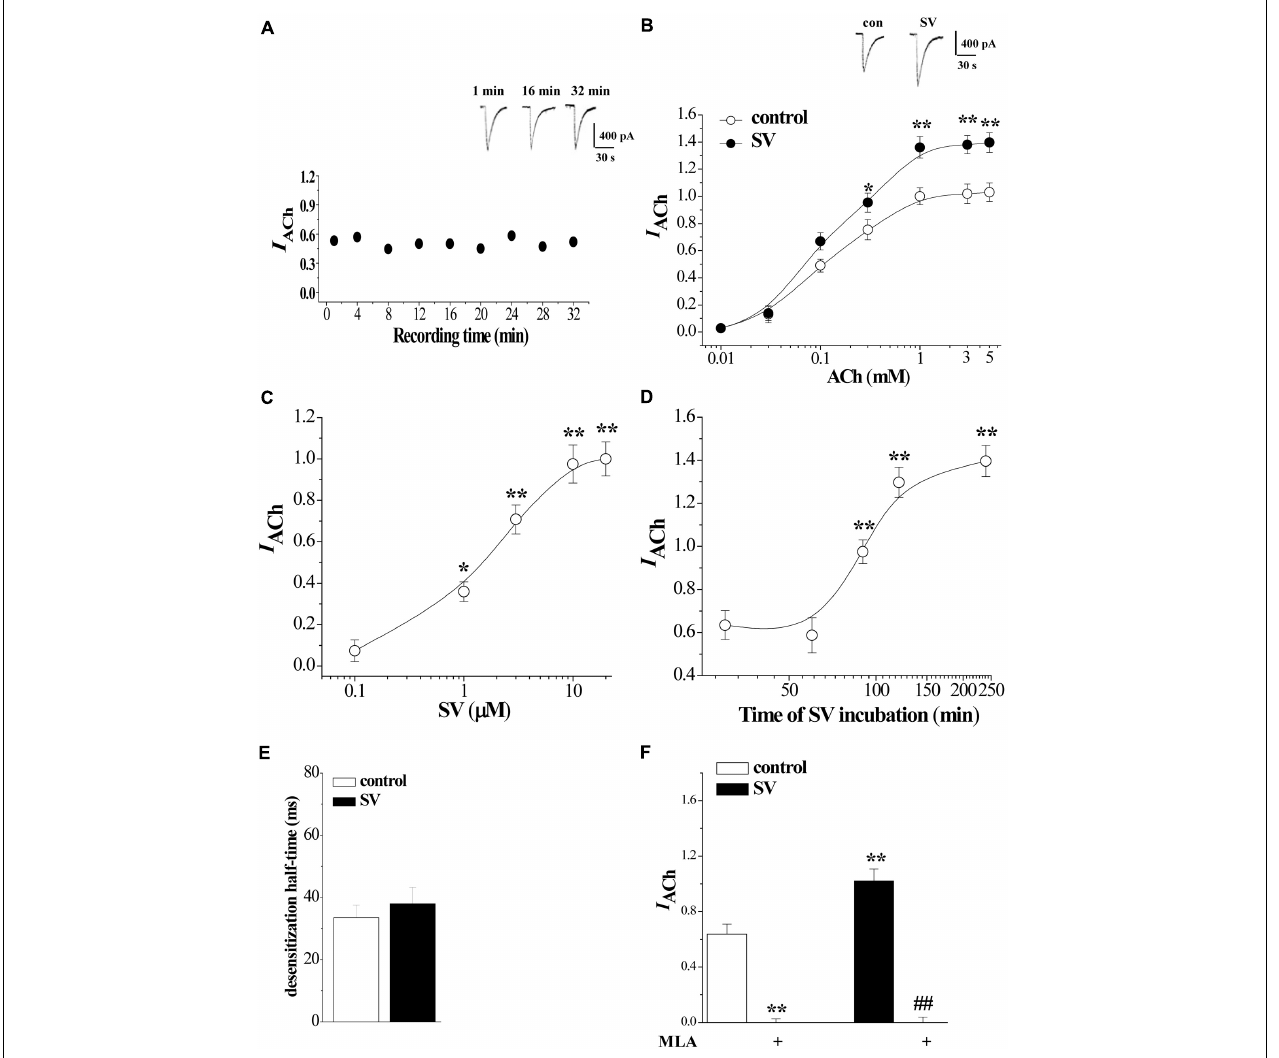
FIGURE 1 | Acute treatment with Simvastatin enhances α 7nAChR activity in hippocampal CA1 pyramidal cells. (A) Repeated applications of ACh (1.0 mM) with 4 min interval evoke whole cell currents ( I ACh ). Representative traces of I ACh evoked at the time of 1, 16, and 32 min. (B) The CA1 pyramidal cells were subjected to consecutive 1 sec applications of 0.01, 0.03, 0.1, 0.3, 1, 3, and 5 mM ACh. Dose-response curves were constructed by the amplitude of I ACh (means ± SEM) that were normalized by a control value evoked by ACh (3 mM). Representative traces of I ACh evoked by 1 mM ACh. ∗ P < 0.05 and ∗∗ P < 0.01 vs. control slices (repeated-measure ANOVA). (C) Evoked I ACh by ACh (1 mM) in the slices treated with SV at 0.1, 1, 3, 10, and 20 µ M for 2 h. Dose-response curves were constructed by the amplitude of I ACh (means ± SEM) that were normalized by the treatment with 10 µ M SV. ∗ p < 0.05 and ∗∗ p < 0.01 vs. vehicle-treated control (repeated-measure ANOVA). (D) Evoked I ACh by ACh (1 mM) in the slices treated with SV (10 µ M) for 30, 60, 90, 120, and 240 min. Time-dependent curves were constructed by the amplitude of I ACh (means ± SEM). ∗∗ p < 0.01 vs. vehicle-treated control (repeated-measure ANOVA). (E) Influence of SV treatment (10 µ M, 2 h) on the desensitization half-time of α 7nAChR. (F) Sensitivity of evoked I ACh to α 7nAChR antagonist MLA. Mean percent reduction in the amplitude of I ACh evoked by ACh (1 mM) following application of MLA (10 µ M) in control slices and SV-treated slices. ∗∗ p < 0.01 vs. control slices; ## p < 0.01 vs. SV-treated slices (two-way